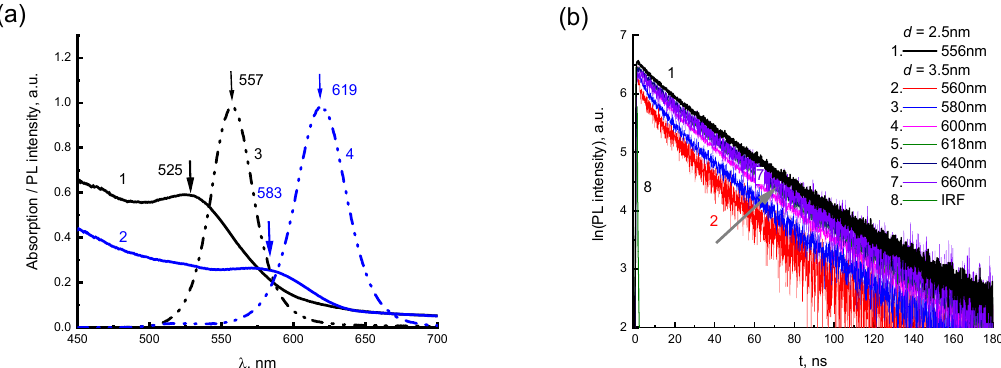
Figure 6. ( a ) Absorption (1,2) and PL (3,4) spectra of aqueous dispersions of CdTe QDs with a diameter of d = 2.5 (1,3) and 3.5 (2,4) nm. ( b ) PL kinetics at various λ EM for aqueous dispersions of CdTe QDs with a diameter of 2.5 (1) and 3.5 (2–7) nm. λ e = 405 nm. T = 296 K.